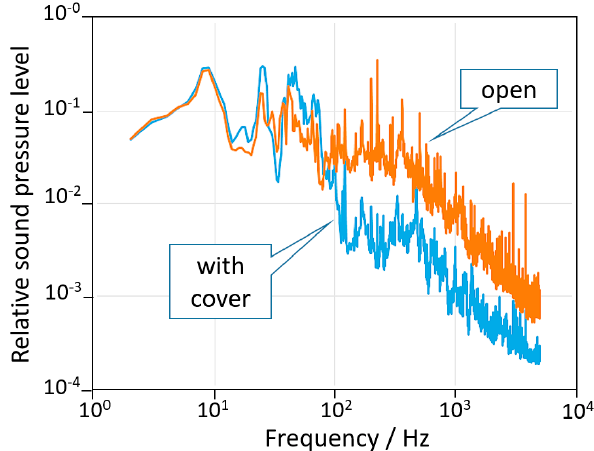
Figure 6. Relative sound pressure spectrum measured in proximity of the AA with and without the wooden cover. The microphone was not calibrated, therefore the vertical scale has been normalized to an arbitrary intensity level. It is evident that the cover is more e ff ective in the acoustic region above 100 Hz and less e ff ective in the 10–100 Hz range dominated by seismic noise. The latter could be reduced by improved damping of floor